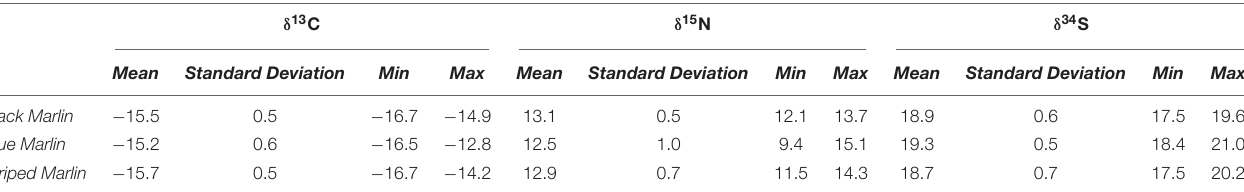
TABLE 3 | Mean ( ± 1SD), minimum and maximum stable isotope ( δ 13 C, δ 15 N, and δ 34 S) values of each of the three species sampled: black marlin ( Istiompax indica ) blue marlin ( Makaira nigricans ), and striped marlin ( Kajikia audax